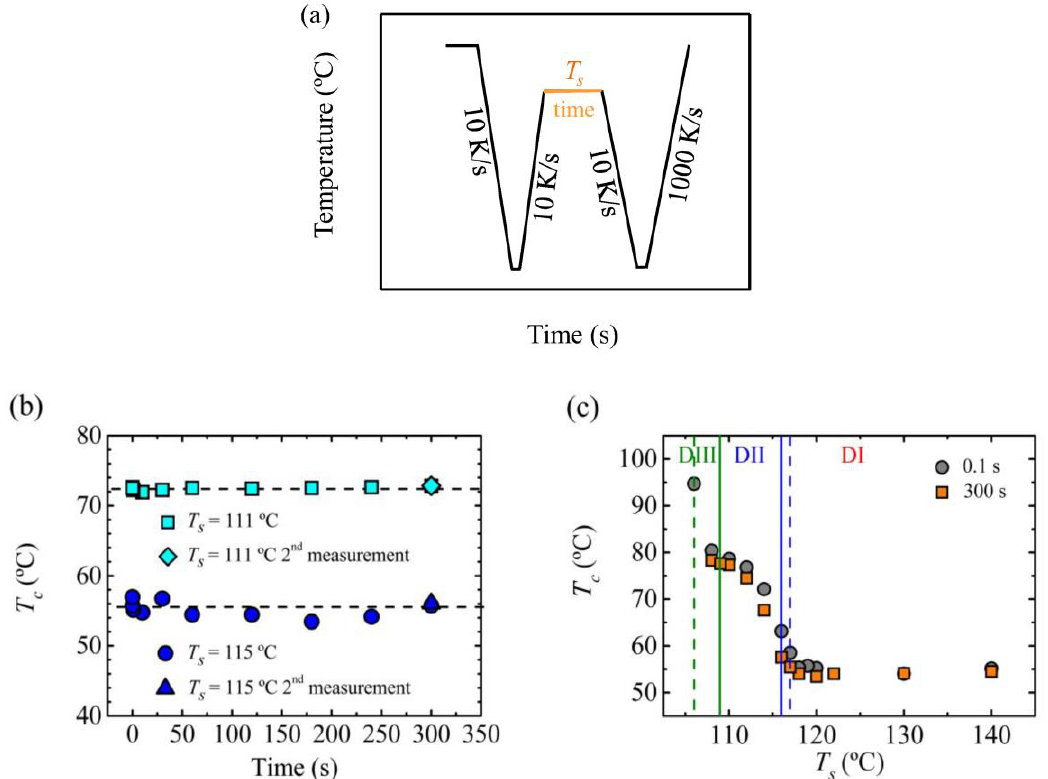
Figure 3. ( a ) Thermal procedure to analyze the effect of time spent at T s temperature, keeping the sample at about 160 °C for 30 s to erase completely the thermal history, and cooling down to −50 °C, the sample is kept at this temperature, −50 °C, for 0.1 s, ( b ) crystallization temperature corresponding to two T s temperatures of Domain II as a function of holding time at T s and ( c ) crystallization temperature as a function of T s temperature spending 0.1 s and 300 s at T s temperature, vertical lines indicate the transition temperature between Domains , dashed lines correspond to 0.1 s and solid lines to 300 s.